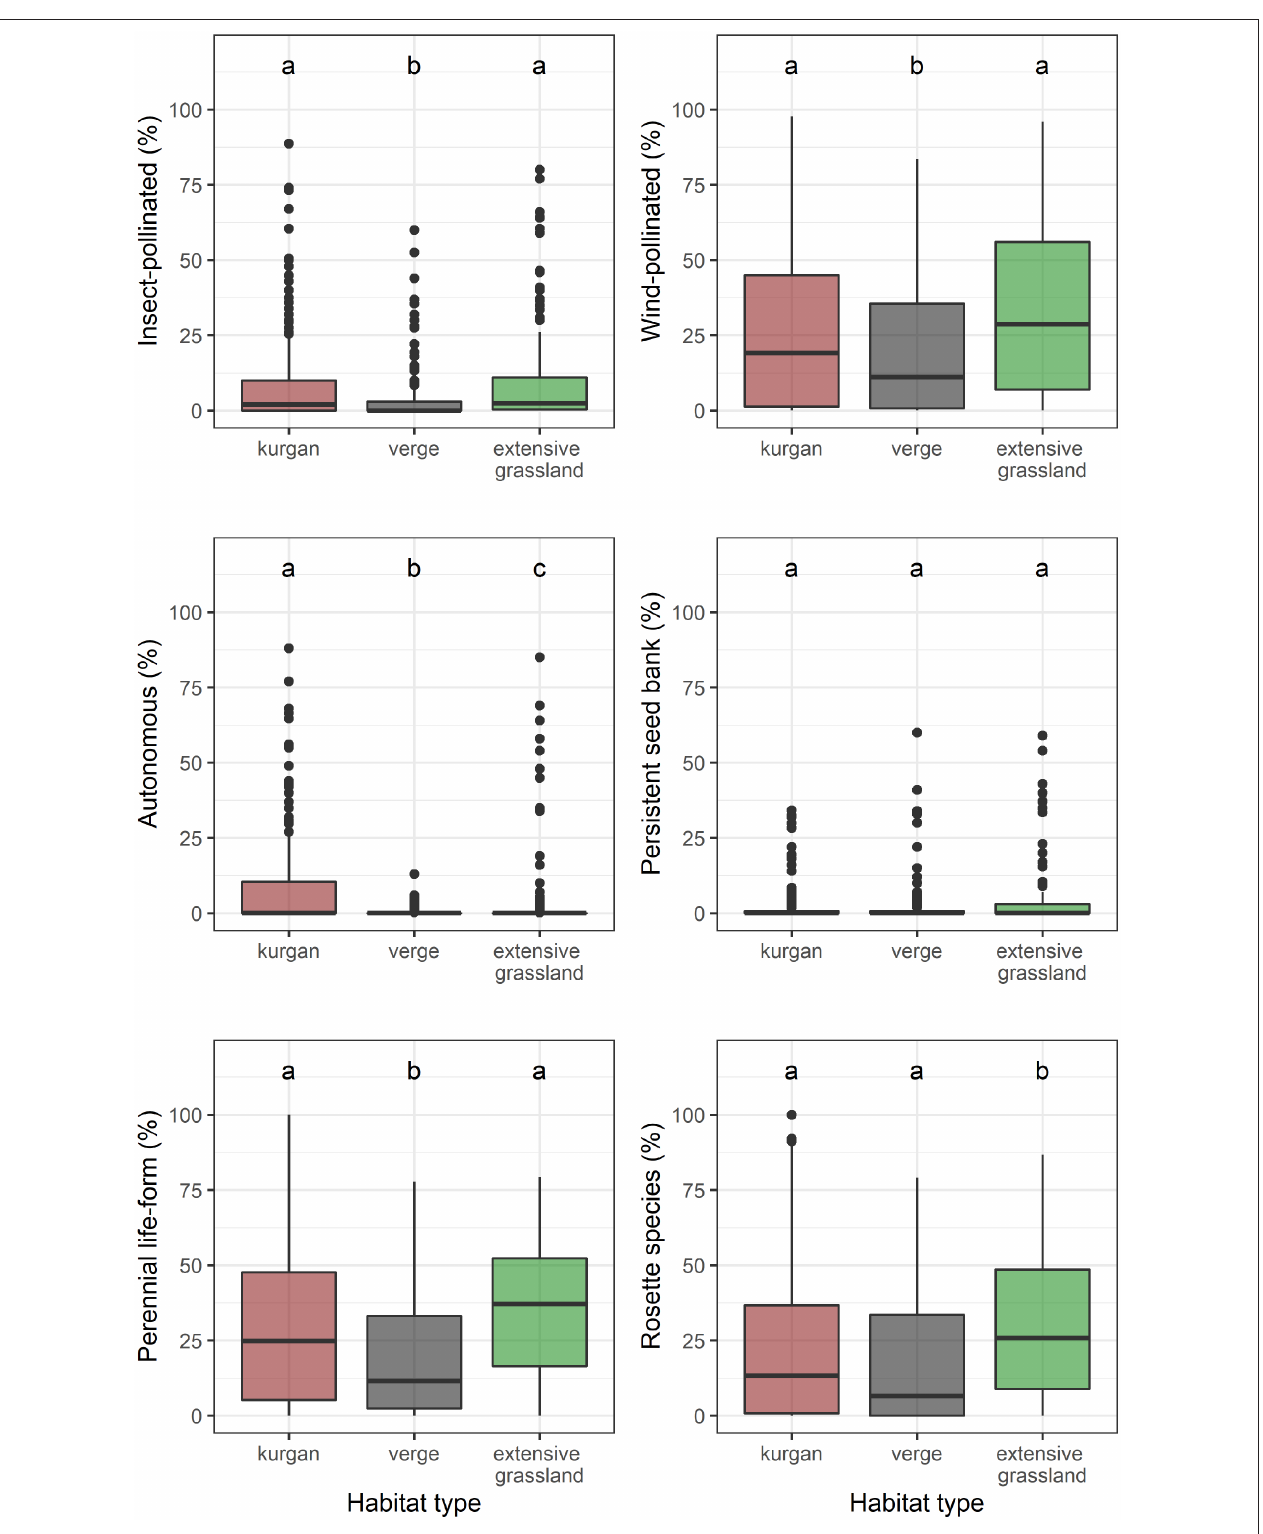
FIGURE 2 | Percentage cover values of specialists belonging to different functional groups observed in the three studied habitat types (kurgans, verges, and extensive grasslands). Boxes, vertical whiskers, bold horizontal lines, and individual dots represent interquartile range (IQR: value range between 25 and 75% quartiles), minimum and maximum value range (excluding outliers), median, and outliers (values being at least 1.5 times the IQR lower than the lower quartile, or 1.5 times IQR higher than the upper quartile), respectively. Different letters denote significant differences between groups (GLMM; p ≤ 0.05 after Tukey’s test).